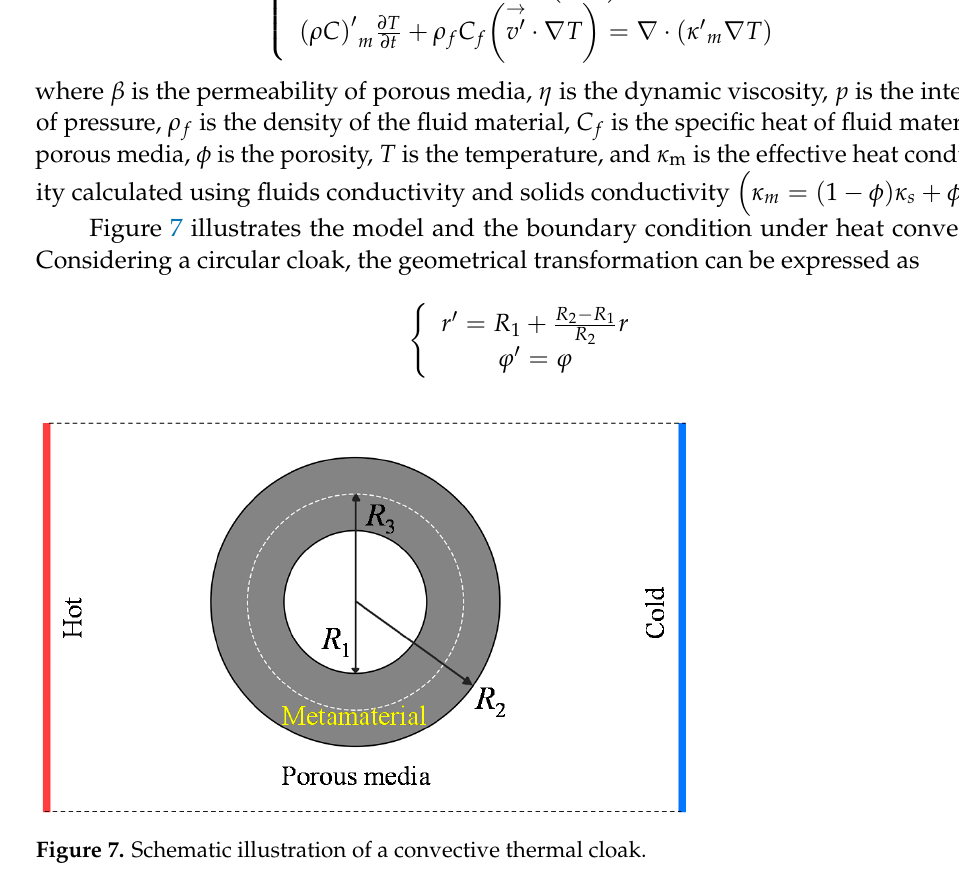
. Figure 8. Schematic diagram of the design and measured temperature distribution [72]. ( a ) The ex- perimental setup and the fabricated sample; ( b–e ) the measured temperature distributions when the rotation rates are 0 rad/min, 0.6 rad/min, 3.6 rad/min, and 100 rad/min, respectively. 3.3. Application One application based on the convective thermal cloak is the thermal meta-device as an analog to zero-index photonics [73]. The zero-index metamaterials [74–76] have been